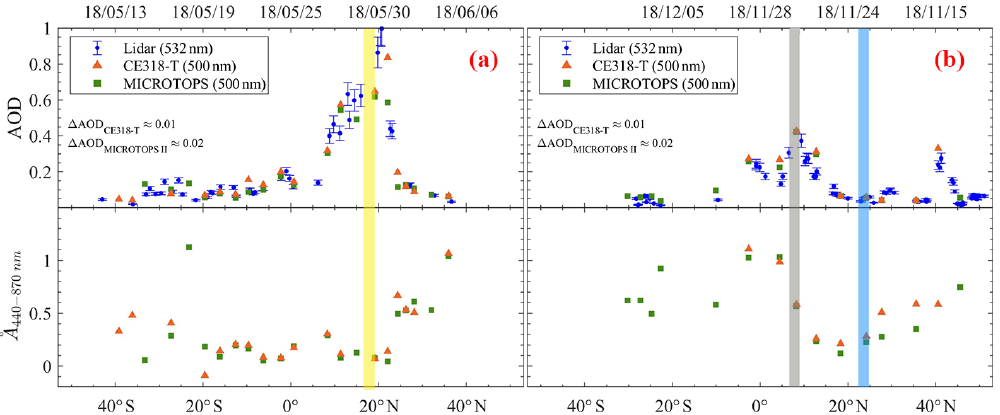
Figure 9. (a) Latitudinal distribution of daily mean AOD measured with Polly XT lidar, MICROTOPS II and shipborne CE318-T. Panels (a) and (b) show the results from PS113 and PS116, respectively. The three vertical colored stripes indicate the cases discussed in Sect. 3.1.2 and 3.2 (yellow: Saharan dust in Fig. 13; grey: diurnal measurements in Fig. 6; blue: pure marine conditions in Fig. 10). Uncertainty in shipborne CE318-T and MICROTOPS II observations was derived according to Smirnov et al. (2009,